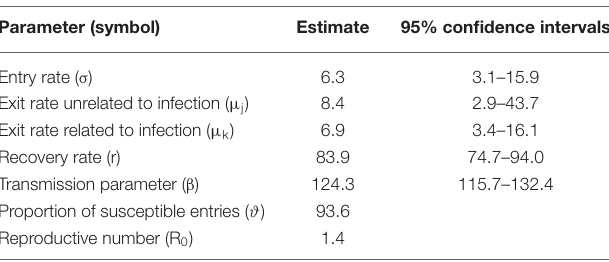
TABLE 4 | Parameter estimates in a negative binomial regression model representing the dynamic of S. agalactiae transmission among the dairy herds of the Emilia-Romagna region.